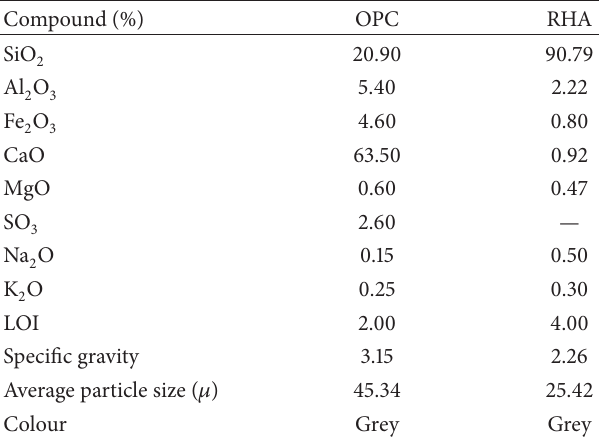
Table 2: Chemical composition and physical properties of OPC and